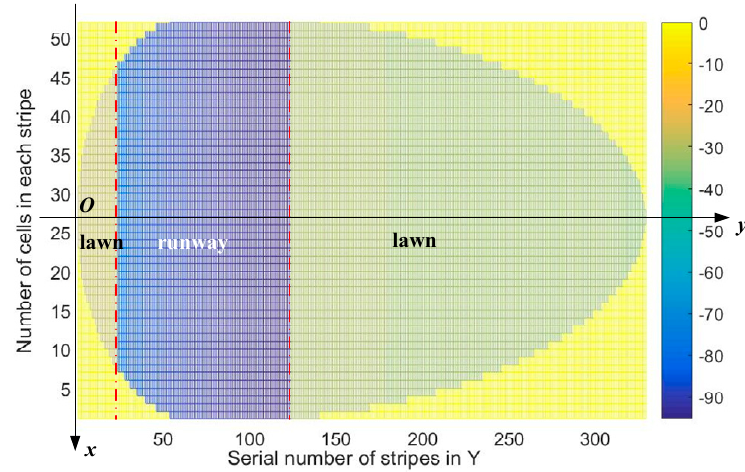
Figure 9. Scattering properties within the radar coverage, on basis of the parameter-modified models in Figure 8a when the cell size is 0.5 m × 0.5 m.